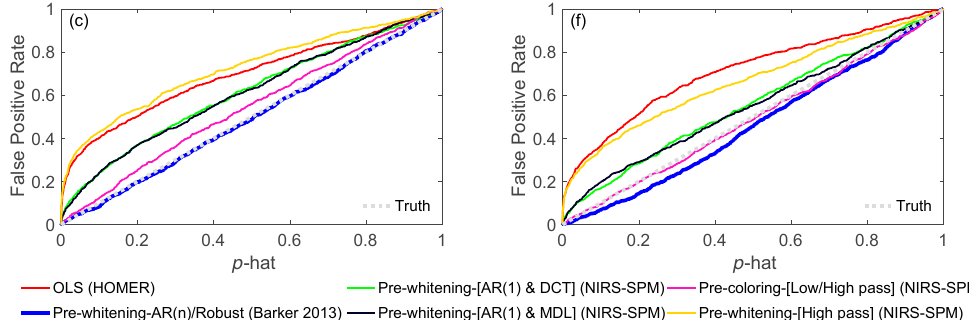
Figure 3. General linear model (GLM) comparison of no motion (left column) and motion-affected (right column). In panels ( a , d ), raw signals with no motion artifacts and with artifacts are shown. After simulations, the ROC curves for the various processing applied to the simulated data are shown in ( b , e ). Panels ( c , f ) show control for type-I errors for the same data and processing. An ideal curve would be along the diagonal (slope = 1), where the reported and actual FPRs would be the same.